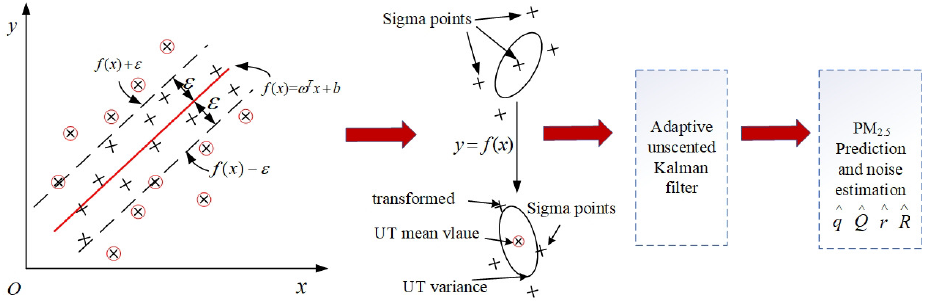
Figure 3. The schematic diagram of the SVR-AUKF algorithm for PM 2.5 concentration